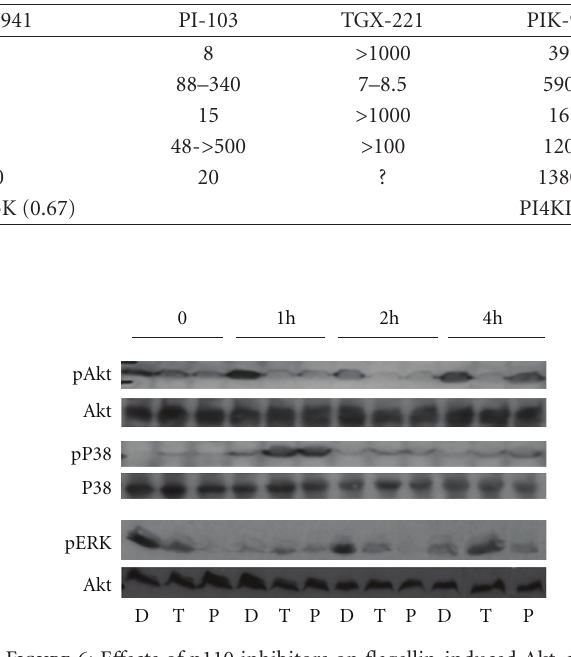
Figure 6: E ff ects of p110 inhibitors on flagellin-induced Akt, p38, and ERK activation. Caco-2 cells were serum-starved overnight, and then given serum-containing media with 10 μ M PI-103 (P) or TGX- 221 (T) or an equivalent volume of DMSO vehicle (D). After 30 minutes, flagellin was added to a final concentration of 100 ng/ml, and cells were harvested after 1, 2, or 4 hours. Total cell lysates were separated by SDS-PAGE and tested for pSer473-Akt, phospho-p38, and phospho-ERK by Western blot. Blots were stripped and probed with total Akt and total p38 antibodies as loading controls. Results shown are typical of three independent